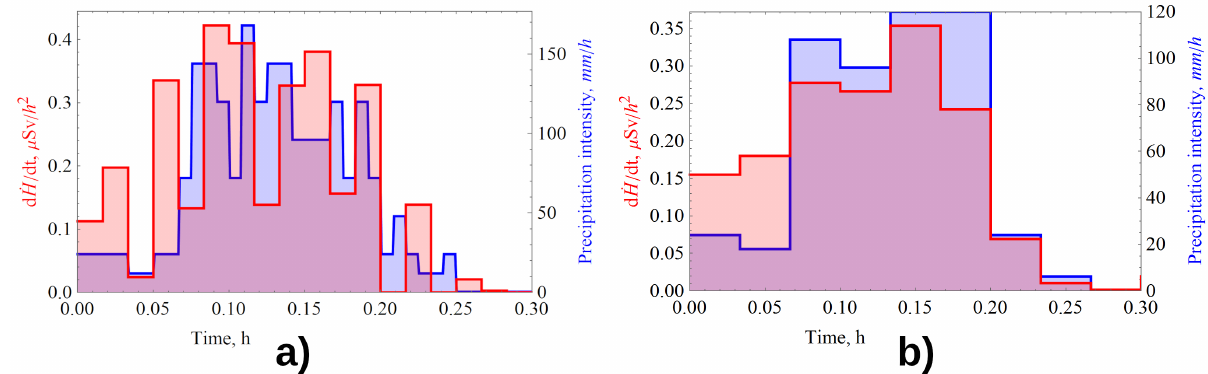
Figure 7. Dynamics of the intensity of precipitation on 30 June (blue) and the time derivative of the measured dose rate (red): ( a ) original data for 1 min; ( b ) averaging of 2 min.